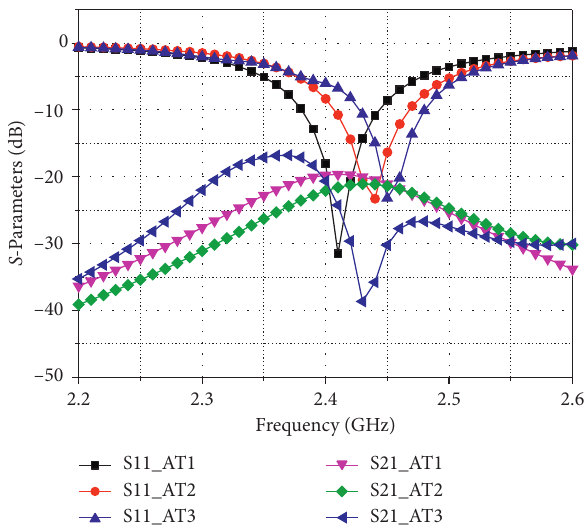
Figure 6: Simulated S -parameters for AT1, AT2, and AT3.